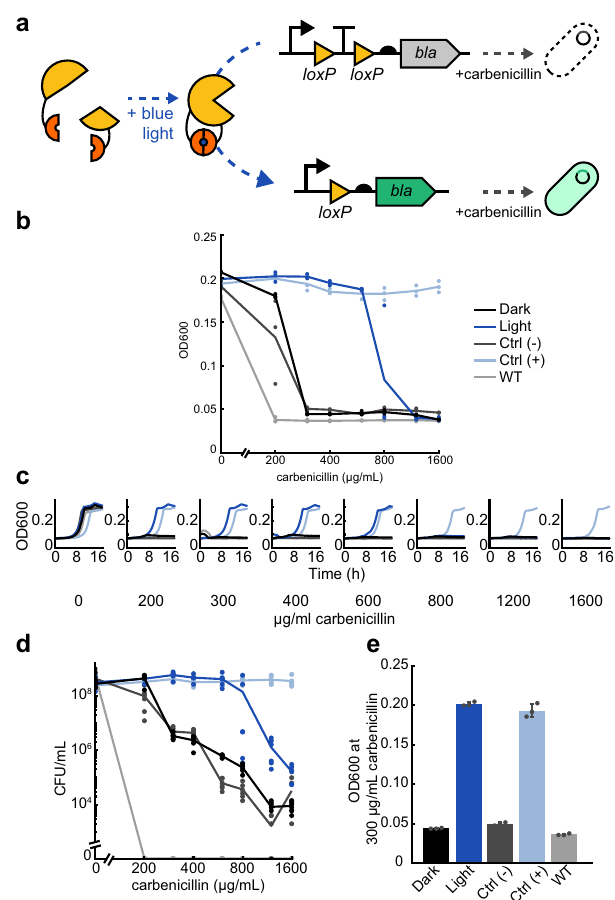
Fig. 1 | Optogenetic activation of beta-lactamase antibiotic resistance using OptoCre- bla . a Split Cre recombinase fragments are linked to blue light-inducible Vvdphotodimerdomains.Whenexposedtobluelight,Crebecomesactiveandcan excise a transcription terminator between two loxP domains, allowing increased expressionofbeta-lactamase( bla ).TheexpressionofOptoCre- bla thenallowscells to survive in the presence of the antibiotic carbenicillin. b Minimum inhibitory concentration (MIC) curves of chromosomally-integrated OptoCre- bla constructs grown in carbenicillin for 18h. Light-induced samples were exposed to blue light for 2h immediately before exposure to carbenicillin. Growth measured by OD600